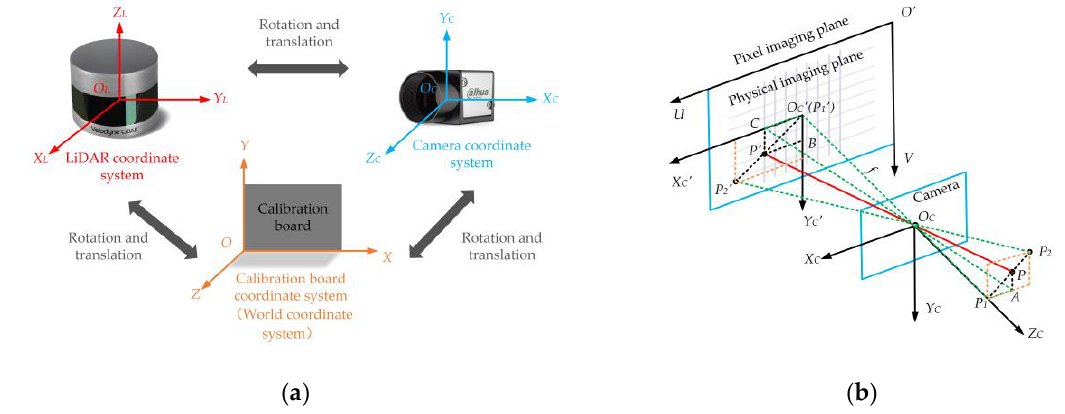
Figure 1. A typical schematic diagram of coordinate system conversion. ( a ) A schematic diagram of the conversion relationship between three typical coordinate systems. ( b ) An ideal pinhole camera imaging transformation model. Abbreviations: LiDAR, light detection and ranging.